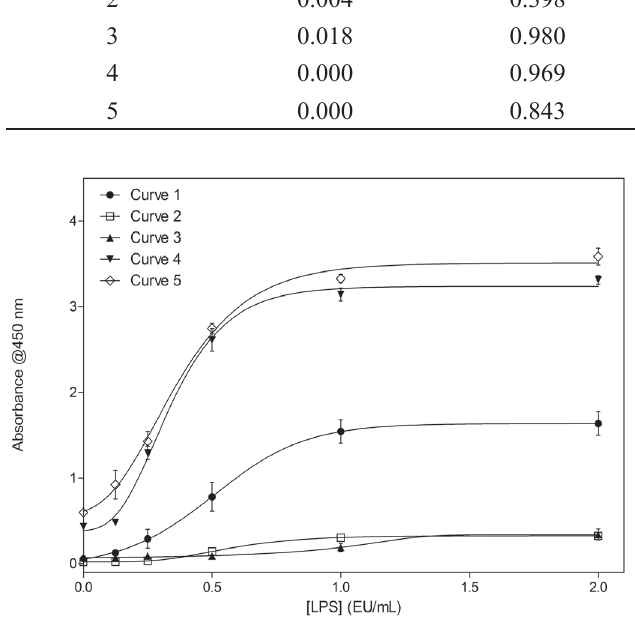
FIGURE 1 - Endotoxin standard curves obtained with cryoblood transported under different conditions. Unmonitored (Curves 1, 2 and 3) and monitored at a stable temperature (curves 4 and